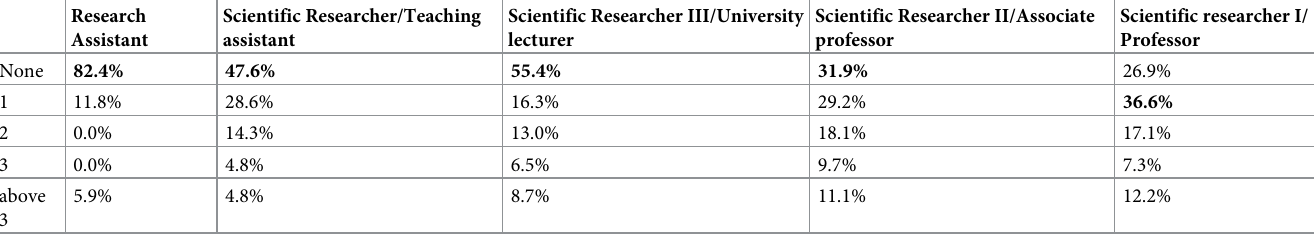
Table 5. Number of applications that obtained funding by didactic or research rank of the